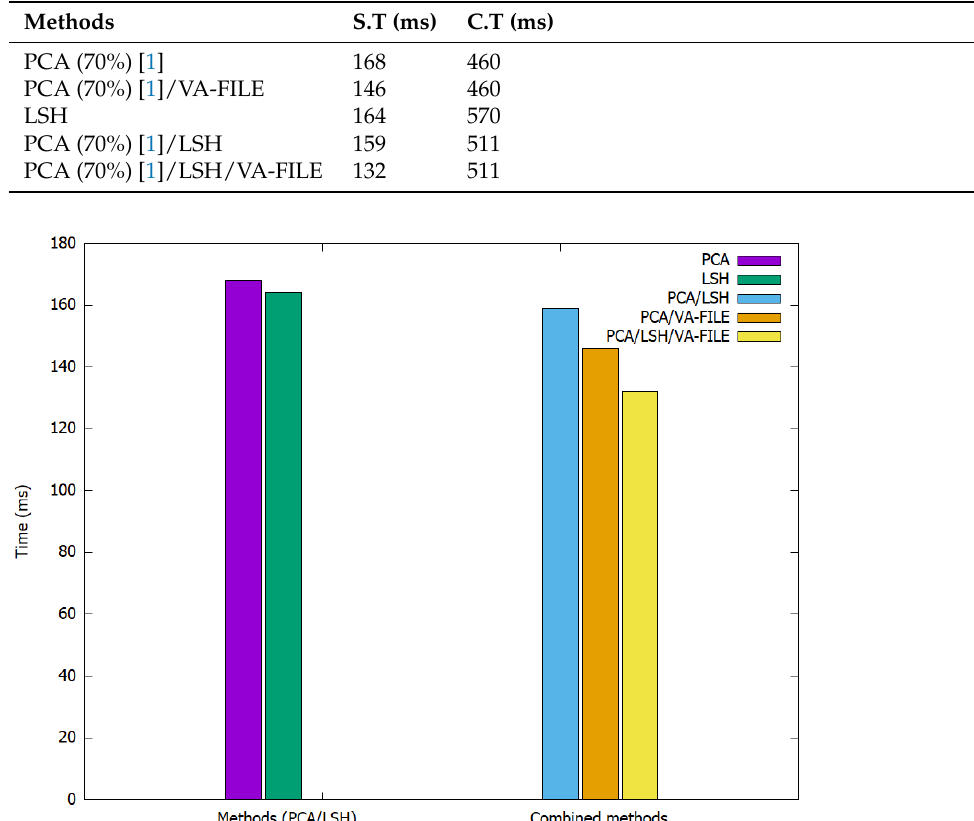
Table 1. Computation (C.T) and the search time (S.T) within Wang database.